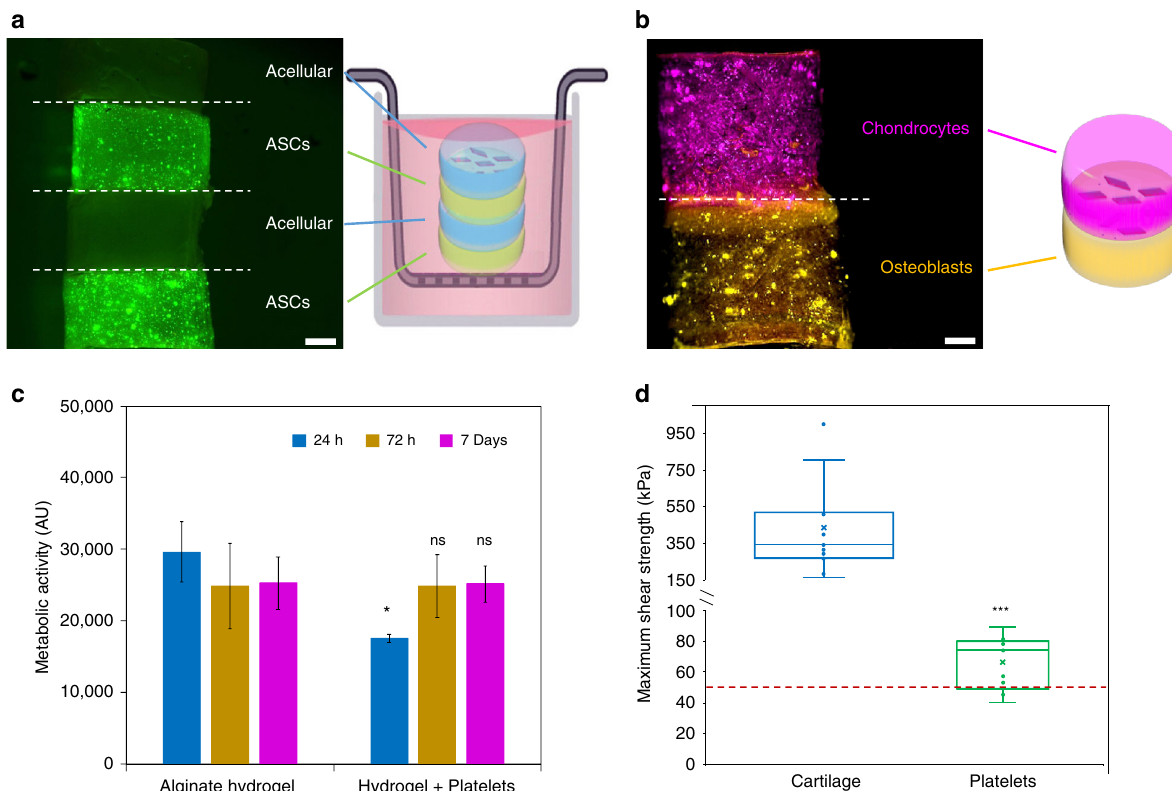
Fig. 5 Cytocompatibility of calcium-alginate NCs and adhesion of cartilage tissue using PLLA 35 - b -PDMAEMA 315 platelets. Confocal microscopy images and schematics of calcium-alginate constructs containing a both acellular and ASCs encapsulated in alternating layers, glued using PLLA 35 - b -PDMAEMA 315 platelets, with cells stained for live(green)/dead(red) cells. b False-color image of labeled chondrocytes (magenta) and osteoblasts (yellow) in separate layers glued together using PLLA 35 - b -PDMAEMA 315 platelets. c ASCs proliferation data when encapsulated on alginate hydrogels and PLLA 35 - b - PDMAEMA 315 platelets enriched hydrogels obtained using Alamar Blue metabolic assay. Statistical analysis was performed using a Welch ’ s unpaired t -test ( p < 0.05, N = 3). d Shear force measurement acquired by lap shear tests on either intact bovine cartilage or cartilage strips adhered with with PLLA 35 - b - PDMAEMA 315 platelets. The red line shows the minimum threshold, from literature, for clinical application in repair of meniscal tears 27 . Statistical